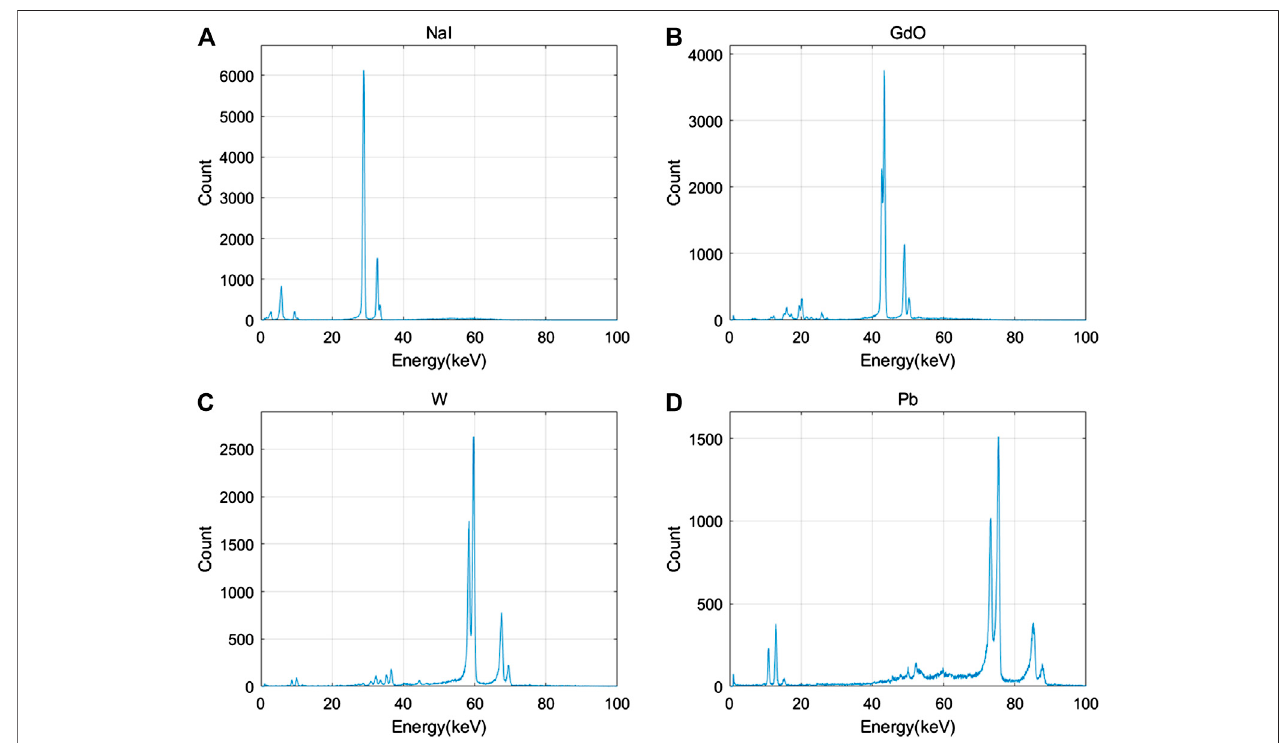
FIGURE 5 | Energycalibrationresults(E (cid:1) 0.0605 × bin+0.14,R-square (cid:1) 0.99998).